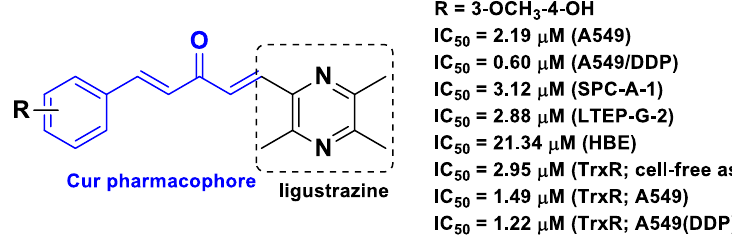
Figure 7. Structure and activity of the most potent chimeric compound developed by Ai et al. [57]. Res-based chimeric hybrids were also obtained by combining the pharmacophore Res and the abovementioned coumarin. In this regard, Belluti et al. synthesized stilbene – coumarin derivatives with excellent antiproliferative and proapoptotic activity against a